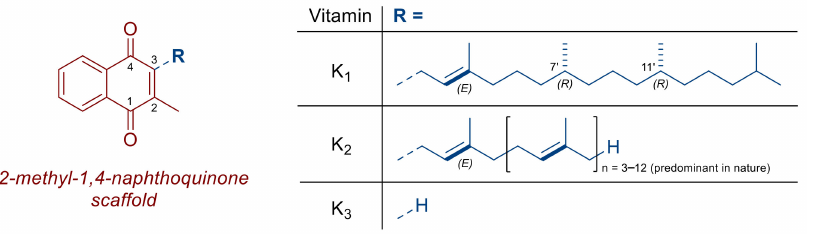
Figure 1. Structure of vitamin